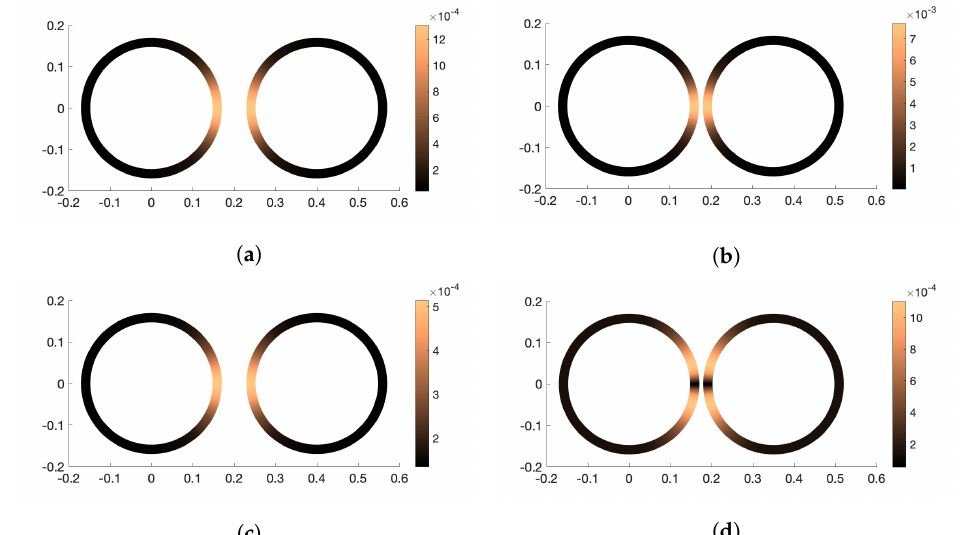
(cid:12) (cid:12) (cid:12) (cid:12) δ ( X ( s )) − u SB ( X ( s )) (cid:12) u (cid:12) for two hydrodynamically interact- C (cid:13) (cid:13) (cid:13) (cid:13) δ ( X ( · )) − u SB ( X ( · )) are ( a ) 0.0013, ( b ) 0.0077, ( c ) (cid:13) u (cid:13) C L ∞ ( T )